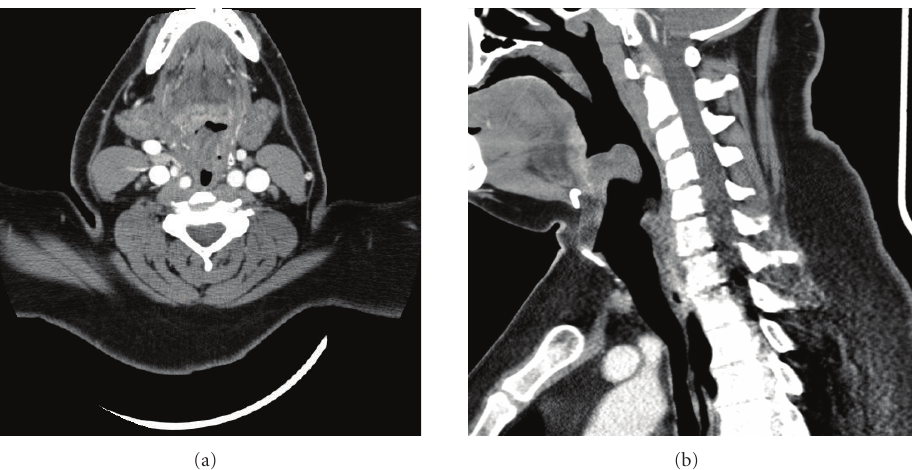
Figure 1: CT scan of the head and neck. (a) Axial and (b) sagittal CT scan images of the neck showing an epiglottic hematoma with moderate narrowing of the airway.